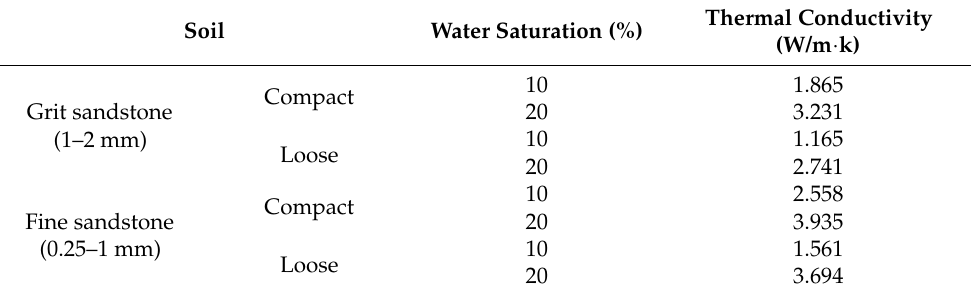
Table 1. Actual thermal conductivity of sandstone under different water saturation conditions.